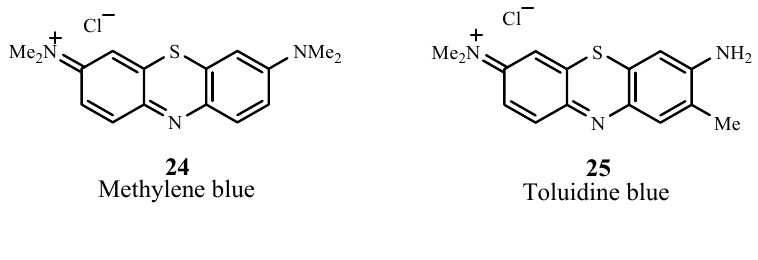
Figure 17. Examples of phenothiazine PDT